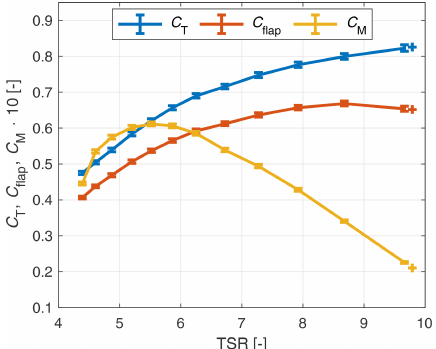
Figure 4. Turbine characteristics for construction of the quasi- steady case. Relevant TSR range for the sine and stochastic wind variation is TSR 5.6 to 9.5 and 5.4 to 9.8,